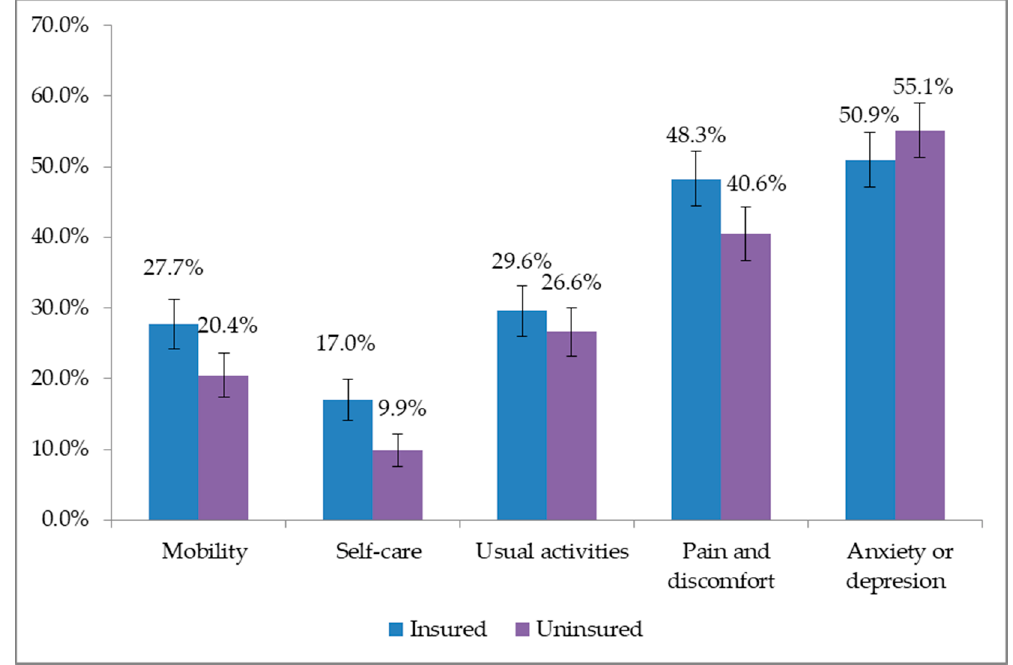
Figure 1. Proportion reported problem in EQ ‐ 5D dimensions between insured and uninsured.